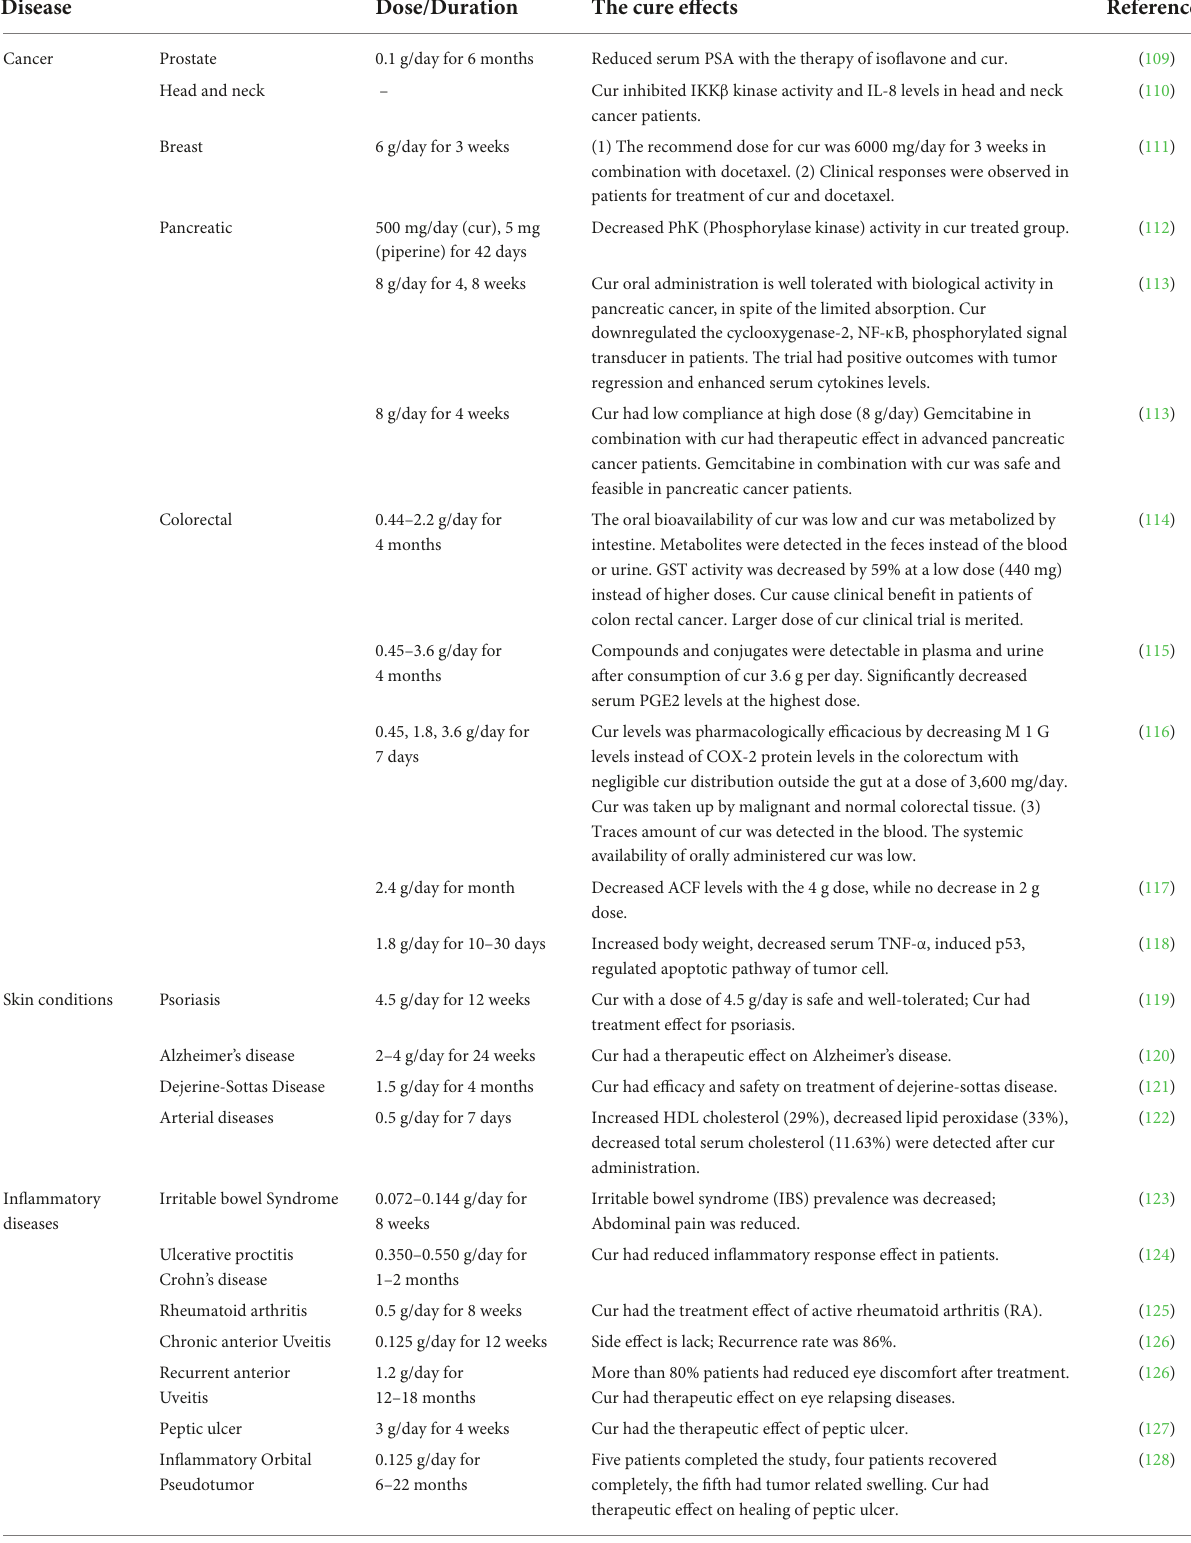
TABLE 3 List of diseases cured by oral administration of bioavailable